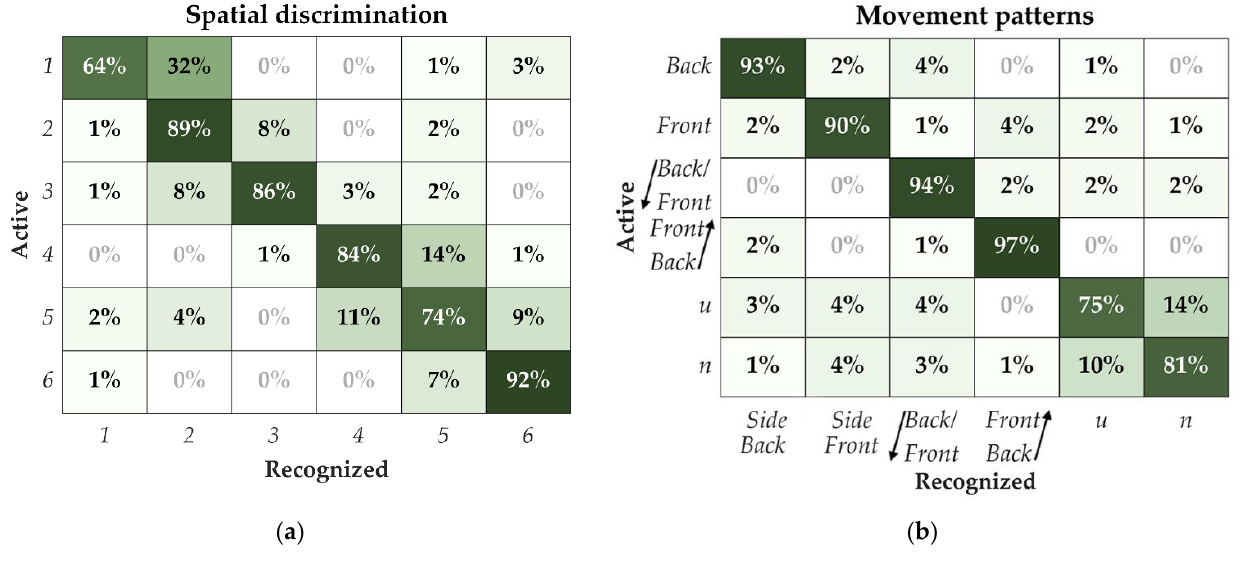
Figure 5. Confusion matrices for ( a ) spatial discrimination of the pads and ( b ) movement pattern recognition. The rows indicate the pad/pattern which was delivered, and the columns report pad/pattern that the subject selected (recognized).